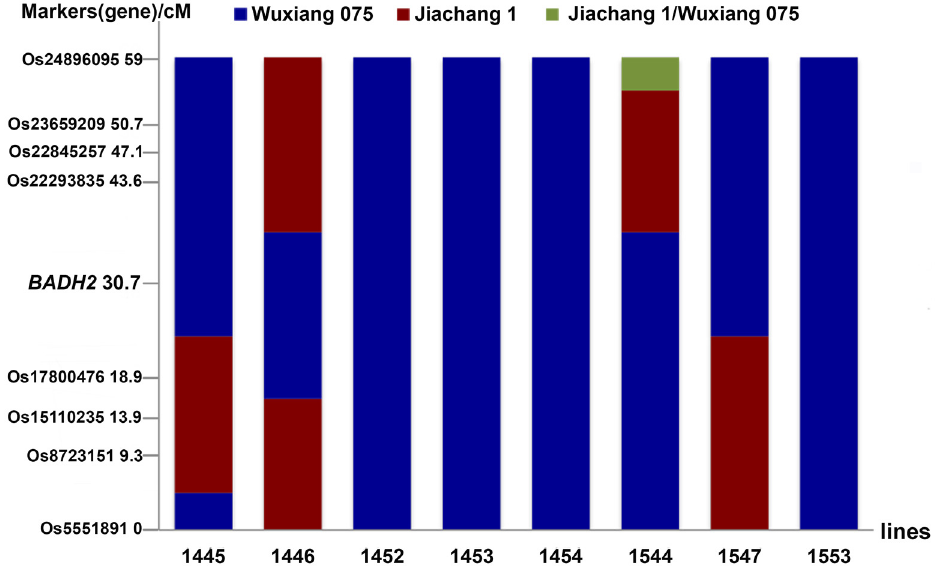
Fig 5. Analysis of genome introgression containing BADH2 fragment in the F7 generations of Wuxiang075/Jiachang1 cross. The X axis shows the 8 lines selected based on two markers Os20105487 and Os20557750; The Y axis indicates the distance distribution of 8 markers for further